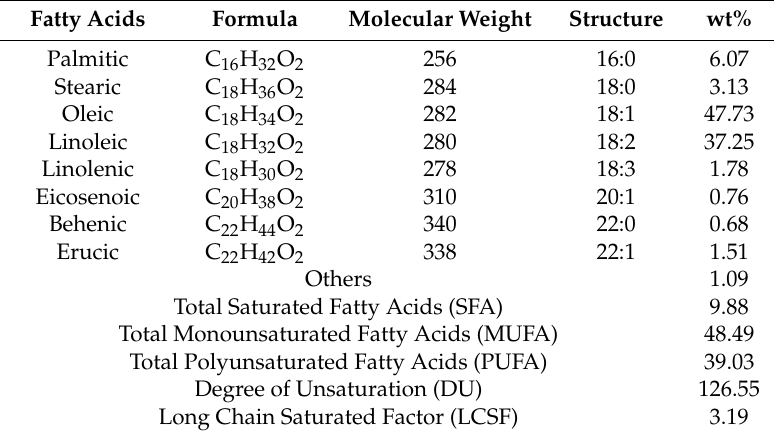
Table 3. PSO biodiesel fatty acid